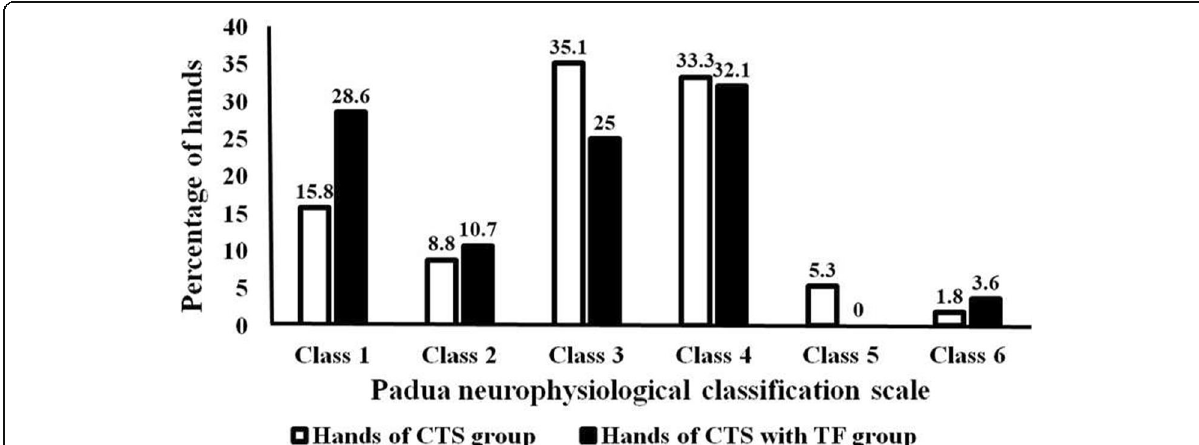
Fig. 7 Bar chart illustrates the lack of statistically significant difference between the carpal tunnel syndrome (CTS) with trigger finger (TF) group versus the CTS group regarding different classes of the Padua neurophysiological classification scale of CTS electrophysiological severity ( X 2 = 3.956, P = 0.556). Hands of the CTS group are presented as white bars. Hands of the CTS with TF group are presented as black bars. The above